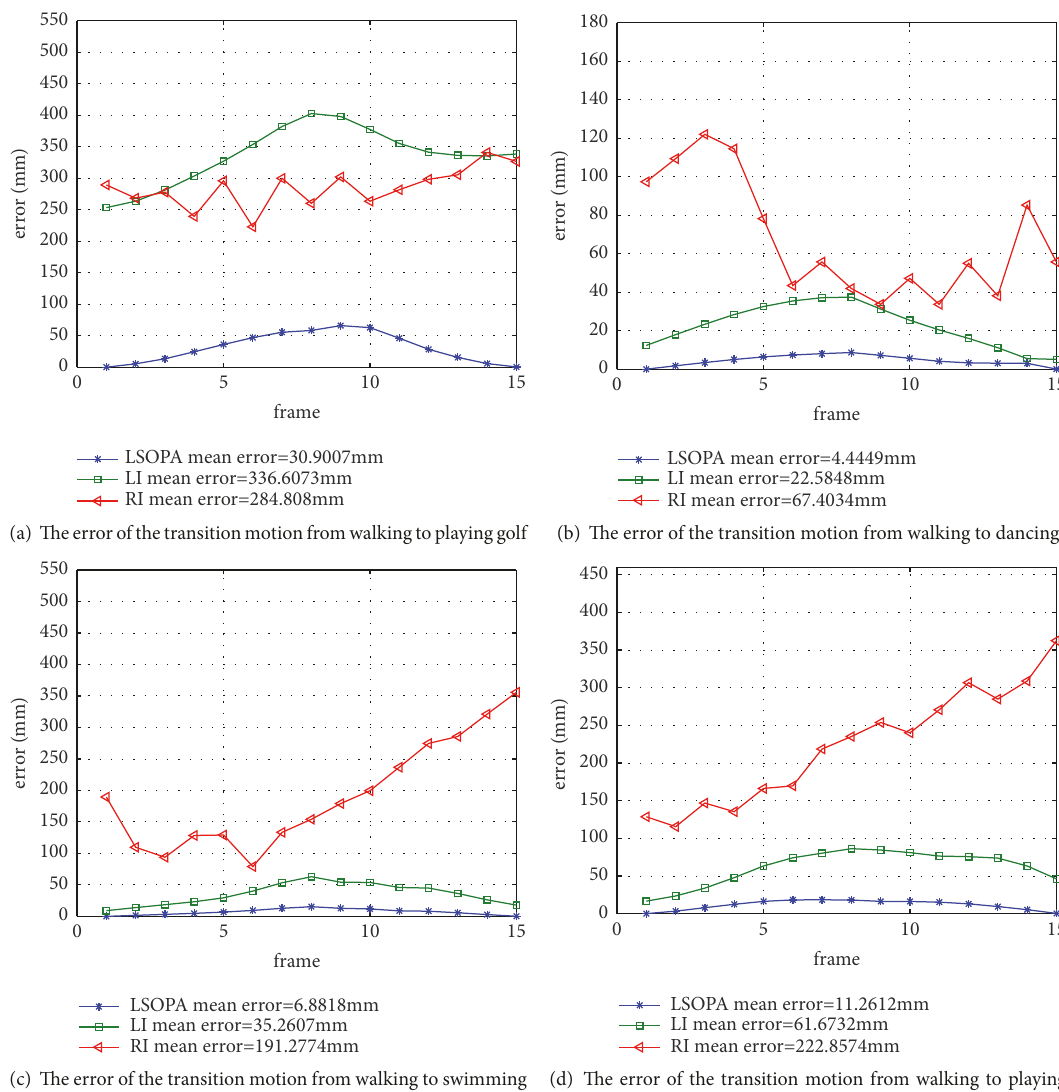
(d) The error of the transition motion from walking to playing football Figure 5: The error of several transition